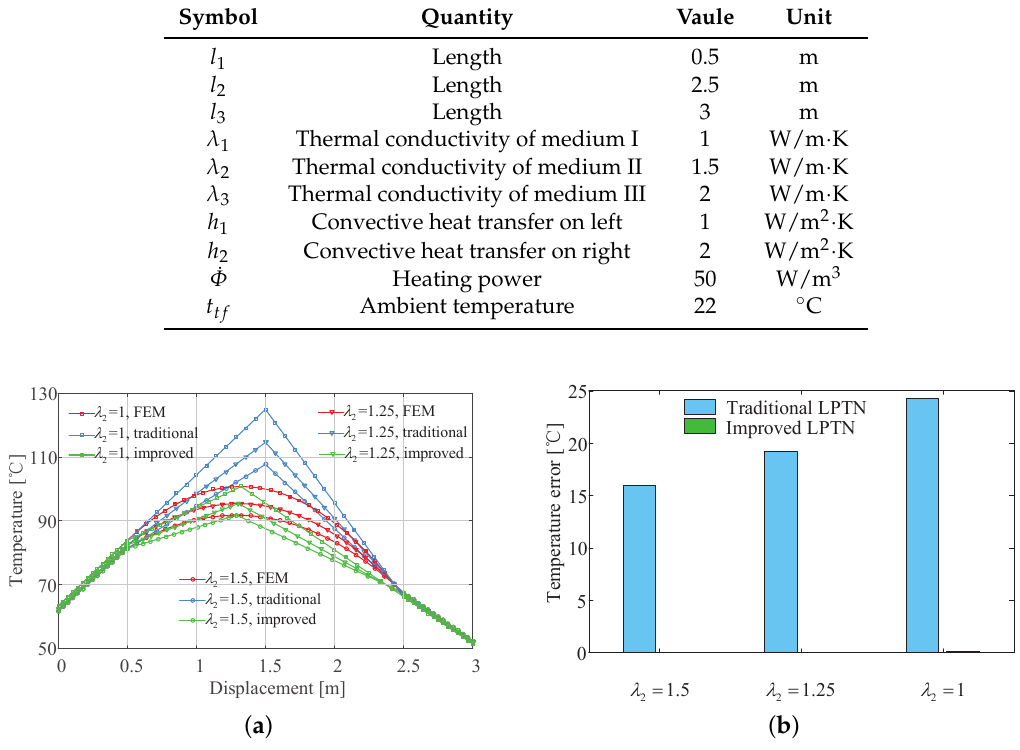
Figure 8. ( a ) Temperature comparison with different thermal conductivities. ( b ) Temperature errors at maximum